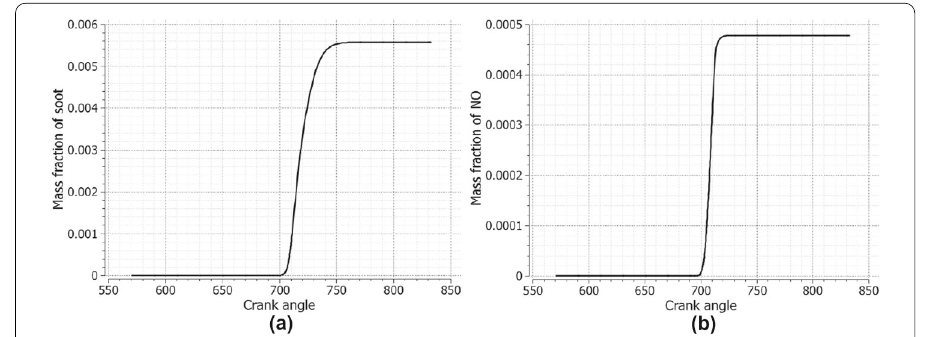
Fig. 6 a Soot mass fraction and b NO mass fraction vs crank